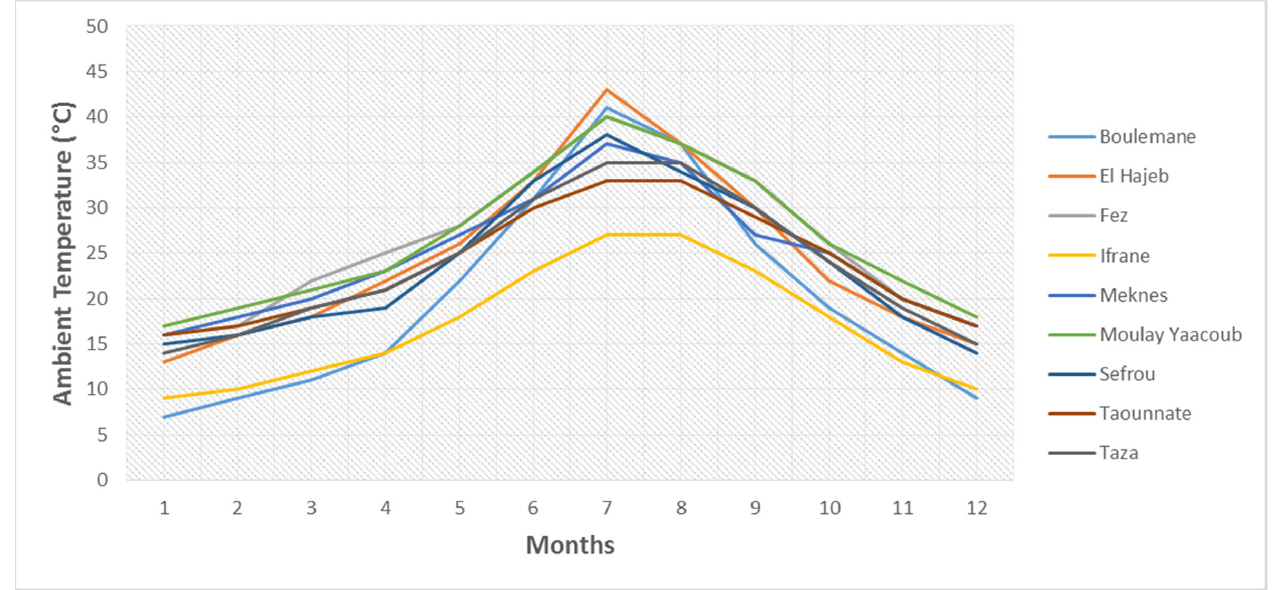
Figure 3. Monthly Average Ambient Temperature in the Region of Fez-Meknes.